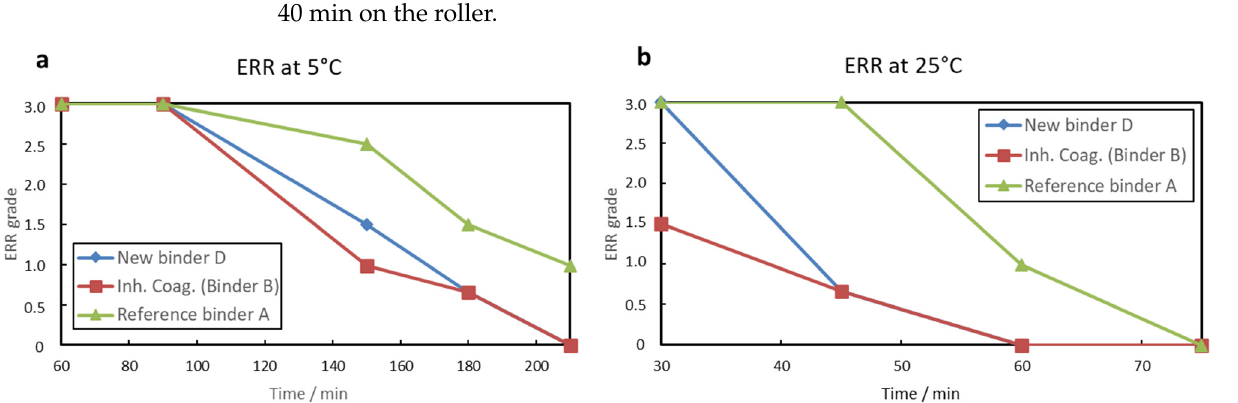
Figure 3. ERR rating of the paints with the reference binder A, the reference binder with inhibited coagulant (Binder B) and the new binder D (containing tertiary polyamine), formulated as shown in Table A1. The tests were carried out according to Section 2.2. ( a ) The humidity at 5 ◦ C was approximately 50%; ( b ) at 25 ◦ C, the humidity was approximately 45%. It should be noted that a small difference in the humidity between 5 and 25 ◦ C was accepted to avoid differences in air movement above the drying films by active ventilation, the latter having a far greater effect on the time to ERR than the former. This is not possible when using a humidity-controlled chamber due to the much lower absolute humidity at 5 ◦ C vs. 25 ◦ C, which requires faster ventilation to hold the relative humidity constant; thus, artificially accelerating the time to ERR at 5 ◦ C.